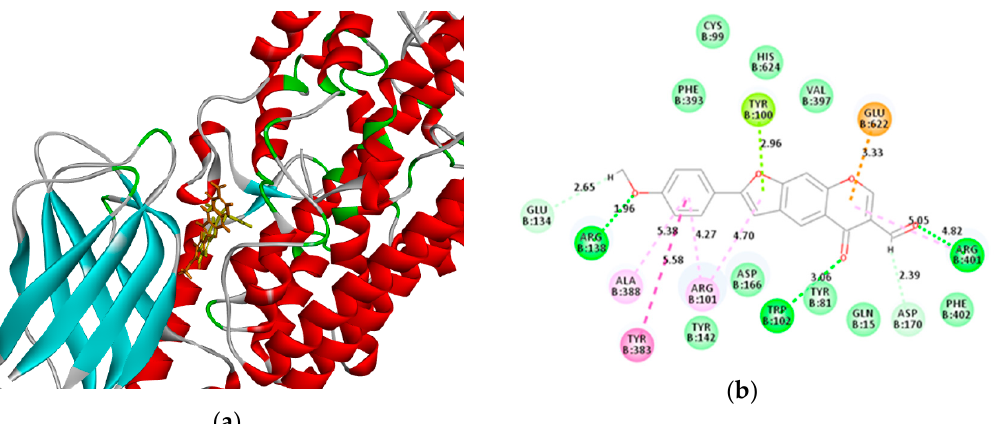
Figure 6. Docking poses of zileuton (yellow) and 2f (orange) represented with LOX-5 (3O8Y) in ribbon format ( a ) and 2D docking plot for 2f including bonding interaction distances ( b ). Bright green represents conventional hydrogen bonds, light green—van der Waals interactions, very light green carbon hydrogen bonds, dark pink—pi–pi interactions, light pink—pi–alkyl interactions, orange— pi–anion or pi–cation interactions, orange—pi–anion interactions and green yellow—pi–lone pair interactions.